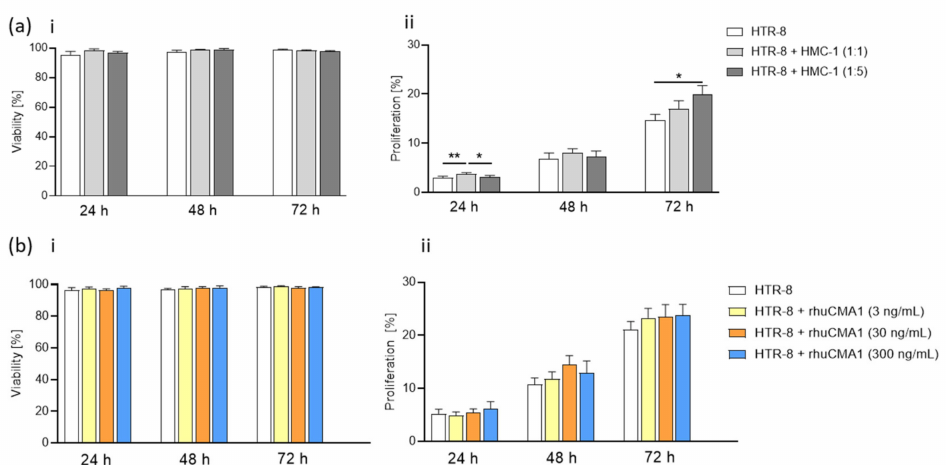
Figure 4. HMC-1 elevates HTR-8/SVneo proliferation. Viability ( a ( i )) and proliferation ( a ( ii )) of HTR-8/SVneo cocultured with HMC-1 cells (HTR-8/SVneo: HMC-1 ratio 1:1 and 1:5) at 24/48/72 h. Viability ( b ( i )) and proliferation ( b ( ii )) of HTR-8/SVneo cells treated with rhuCMA1 (3 ng/mL, 30 ng/mL, 300 ng/mL) at 24/48/72 h. The results are presented as a mean with SEM. Statistical analysis was performed with the one-way ANOVA or Friedman test (* p < 0.05, ** p < 0.01). HTR-8: HTR-8/SVneo; rhuCMA1: recombinant human